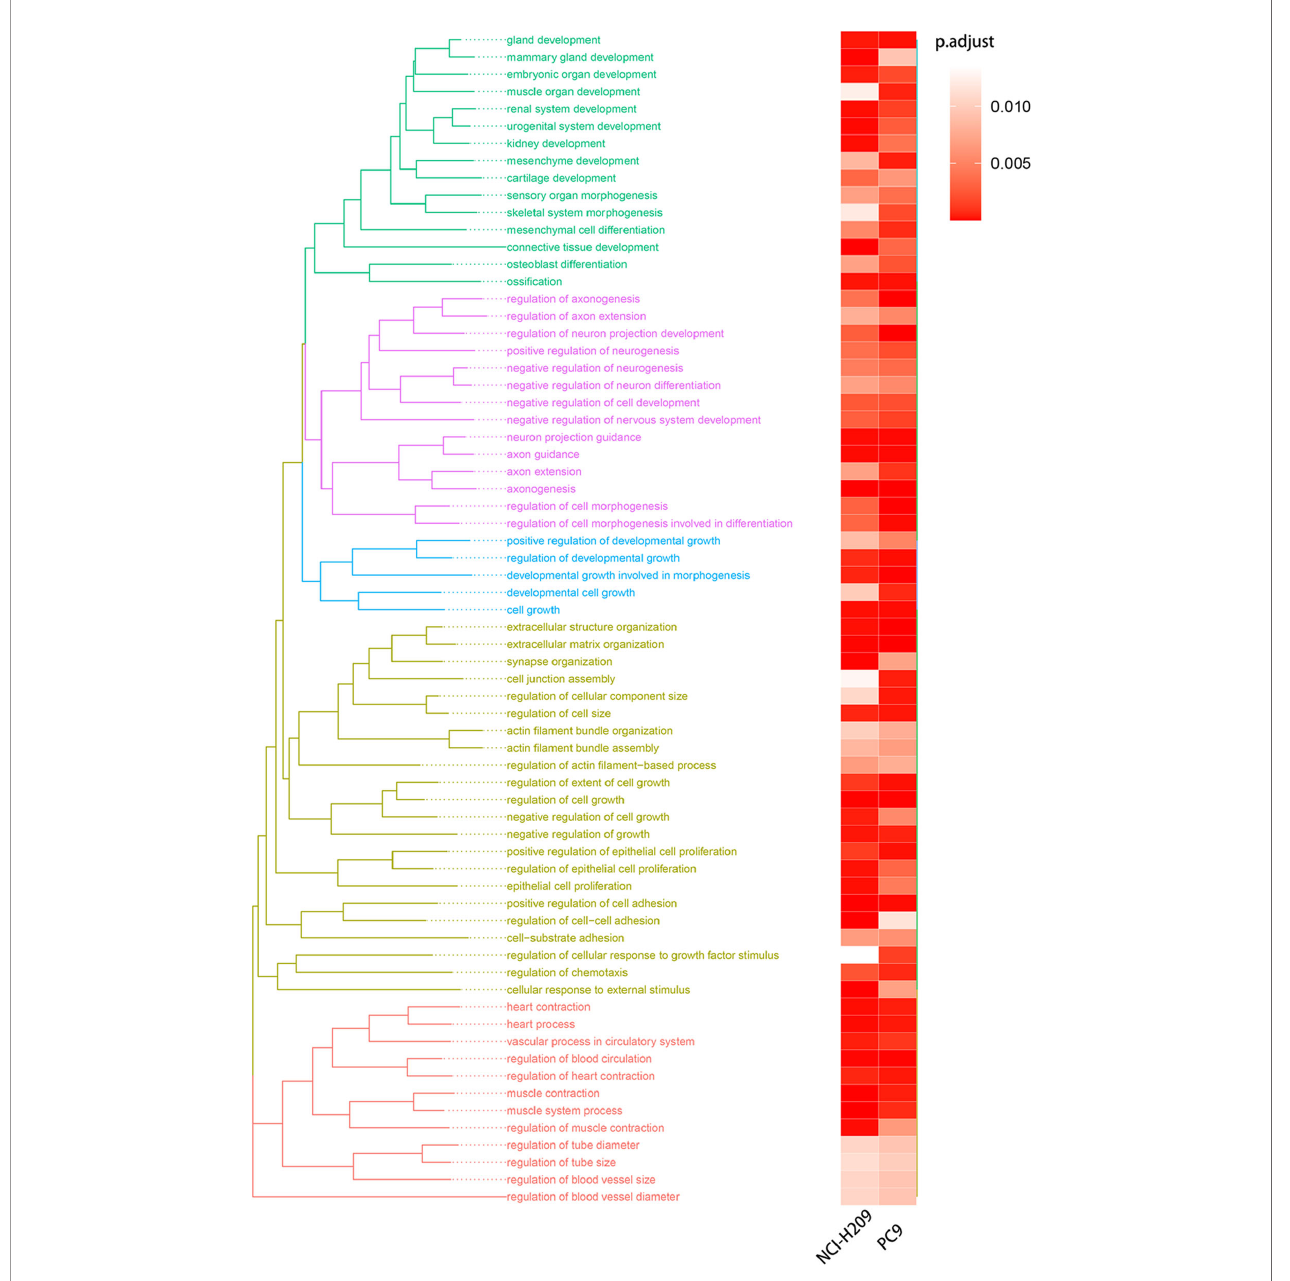
FIGURE 4 | Semantic similarity clustering analysis. The terms of BP co-enriched signi fi cantly by the co-cultured NCI-H209 cells and brain metastatic PC9 were used for clustering